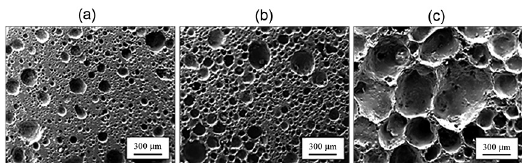
Figure 7: SEM micrographs of glass foams fired at 800 °C for 30 min. (a) 30%, (b) 40%, (c) 50%